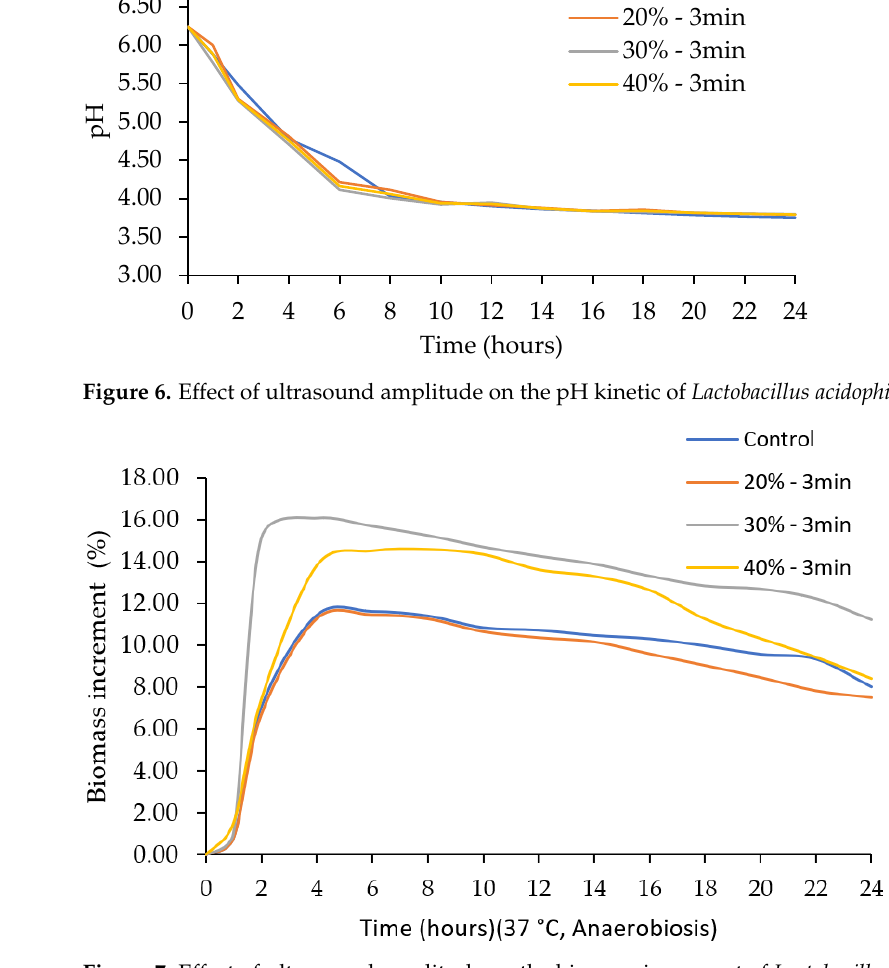
Figure 7. Effect of ultrasound amplitude on the biomass increment of Lactobacillus acidophilus.